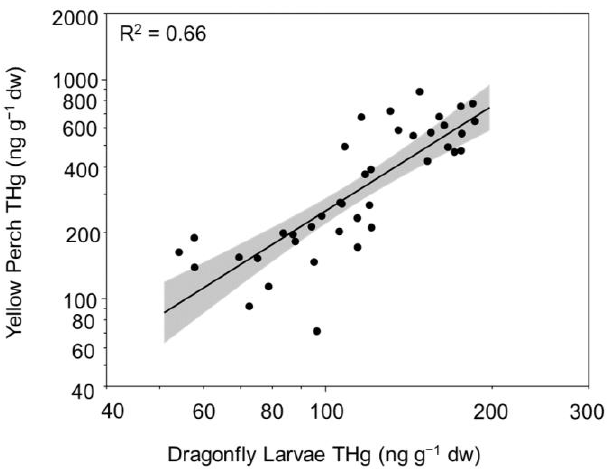
Figure 7. Total mercury (THg) concentrations in age-1 yellow perch in relation to dragonfly larvae (Aeshnid equivalent) 445